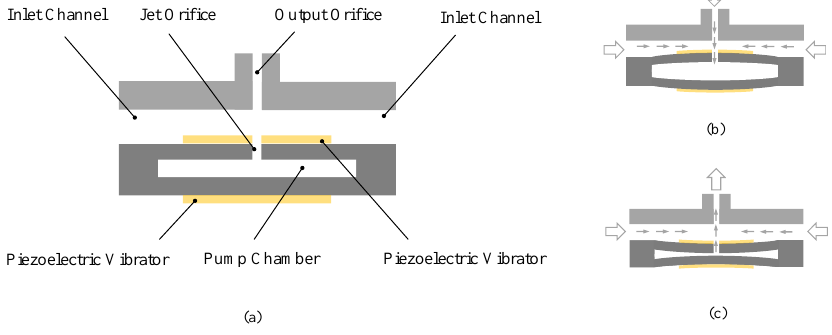
Figure 1. Working process of the pump: ( a ) static state; ( b ) supply process; ( c ) pump process.